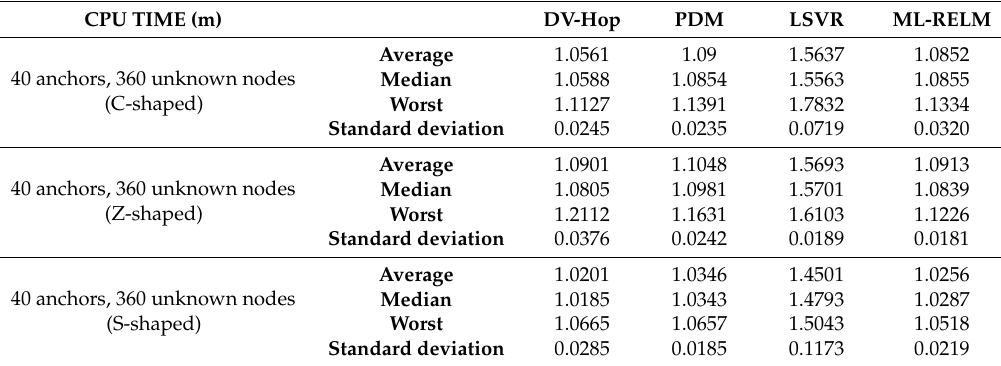
Table 2. Running time in the random deployment.